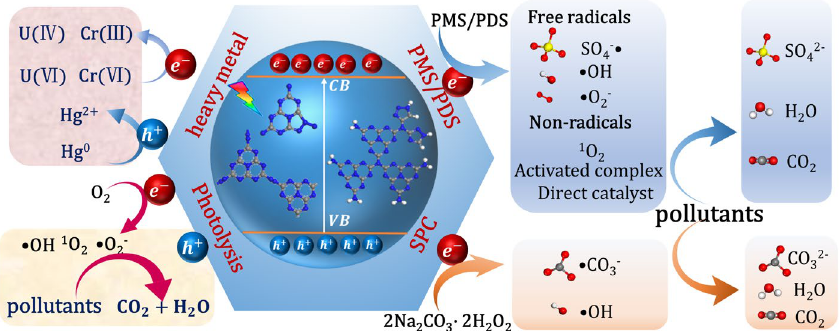
Figure 19. Photo-degradation processes of pollutants by g-C 3 N 5 -based materials.